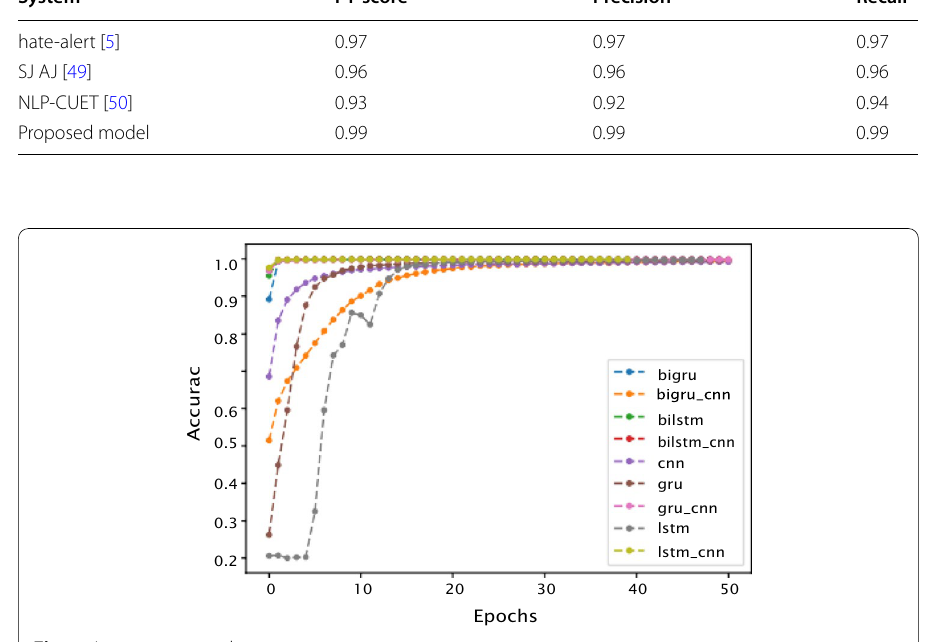
Fig. 4 Accuracy vs